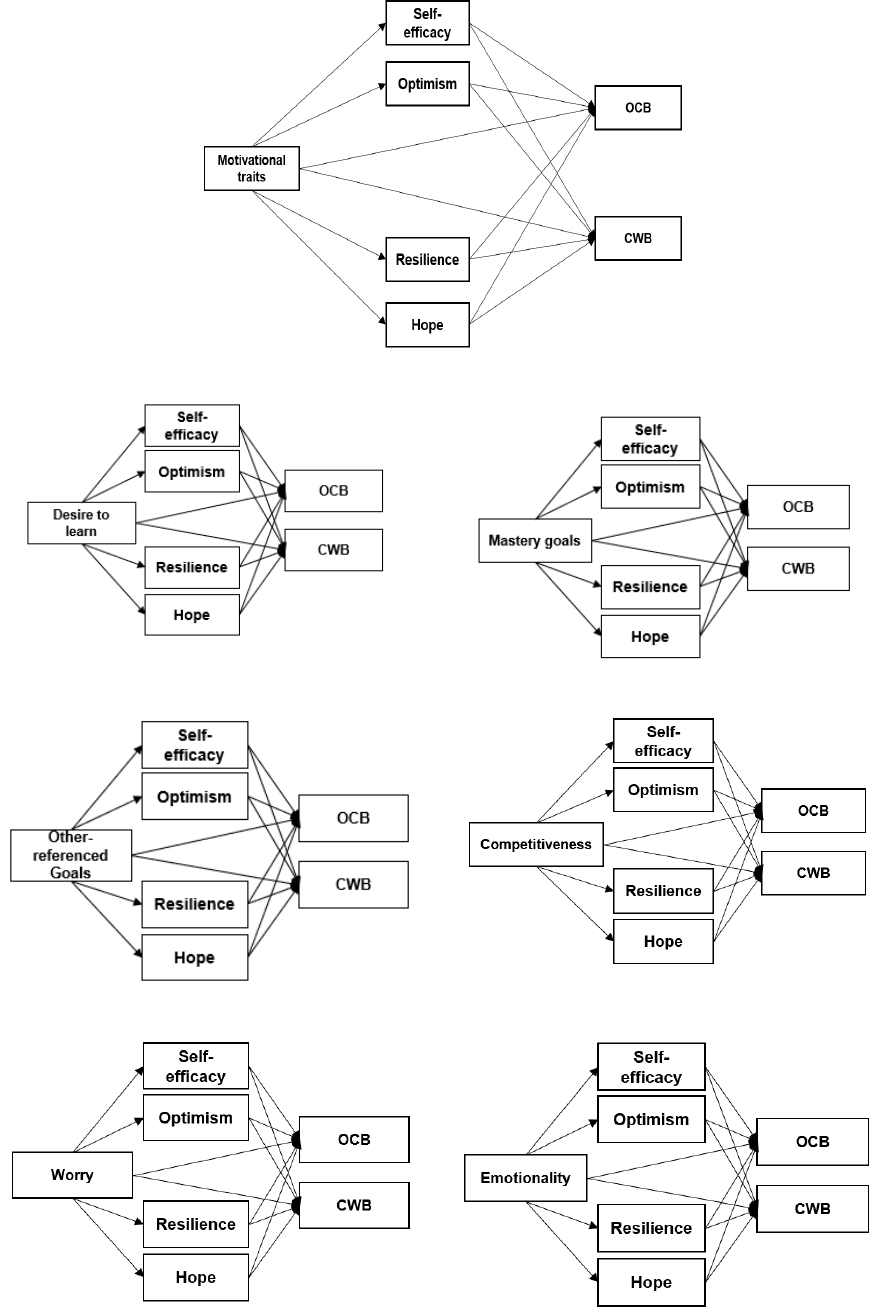
Figure 1. General mediation model proposed and tested models